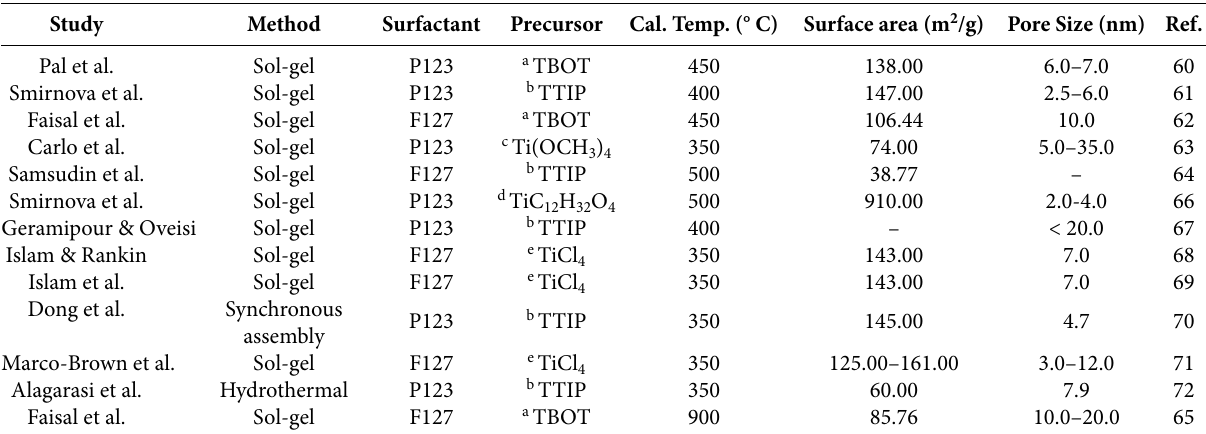
Table 2. Summary of preparation methods using non-ionic surfactants as SDA. Study